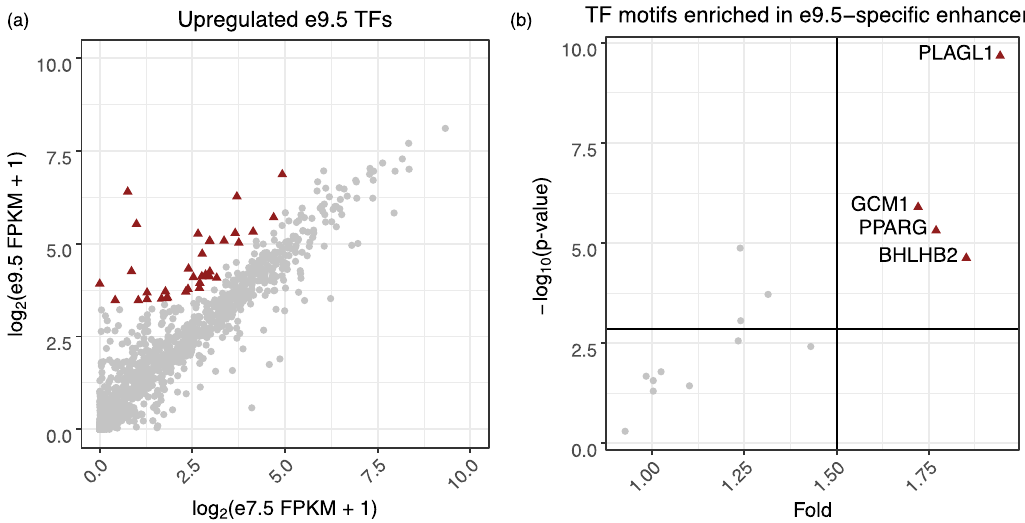
Figure 2. The PLAGL1 motif is enriched in e9.5-specific enhancers and is associated with blood vessel development genes. ( a ) Scatterplot showing the expression of all TFs at e7.5 and e9.5. Upregulated TFs at e9.5 are indicated by maroon triangles (fold ≥ 2, and p -value ≤ 0.05). ( b ) Of the 37 transcription factors upregulated at e9.5, four TFs (maroon triangles) pass the fold and Bonferroni corrected p -value thresholds (black lines).